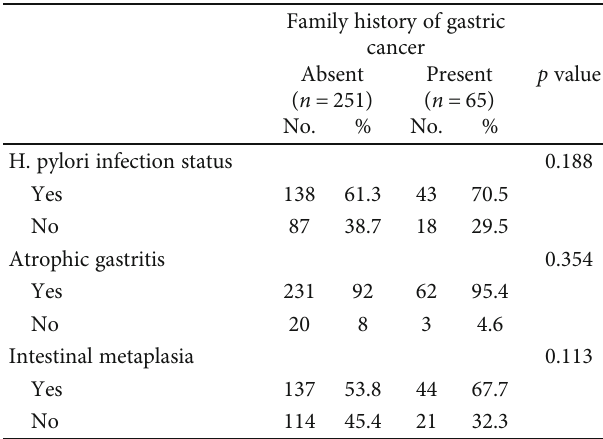
Table 2: Clinicopathologic fi ndings of gastric cancer